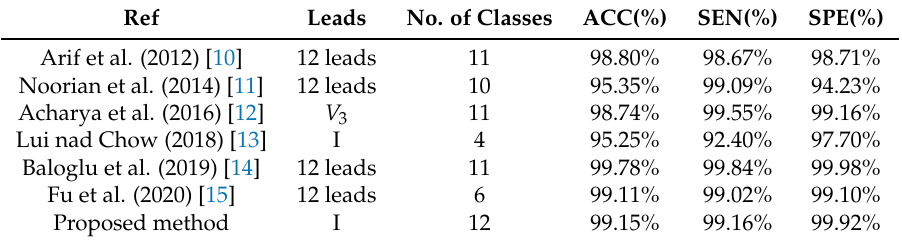
Table 10. Comparison of this study with other studies using the PTB diagnostic database. Ref Leads No. of